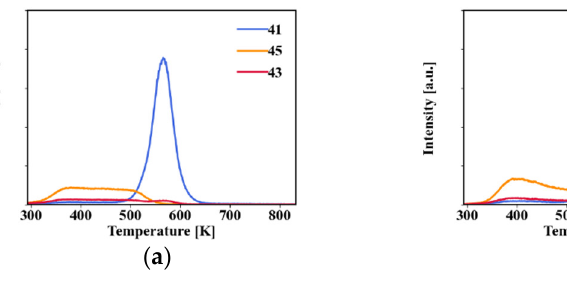
Figure 4. TPD data for the reaction of isopropanol on ( a ) Na-free ZrO 2 ( b ) 1 wt% Na-ZrO 2 ( c ) 2 wt% Na-ZrO 2 : isopropanol-m/e 45; propene-m/e 41 at high temperature; acetone-m/e 43 at high temperature.